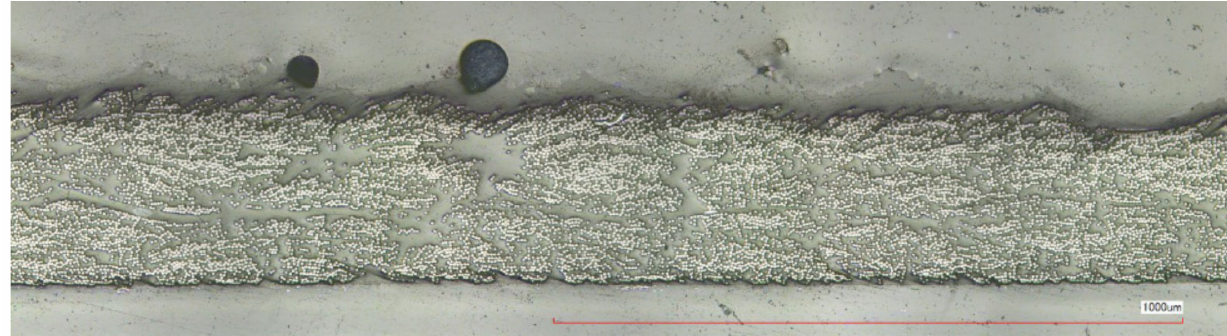
Figure 8. Cross-section optical micrograph of TUFF recycled fiber composite produced using VARM processing. Reprinted with permission from [45]. Copyright 2019